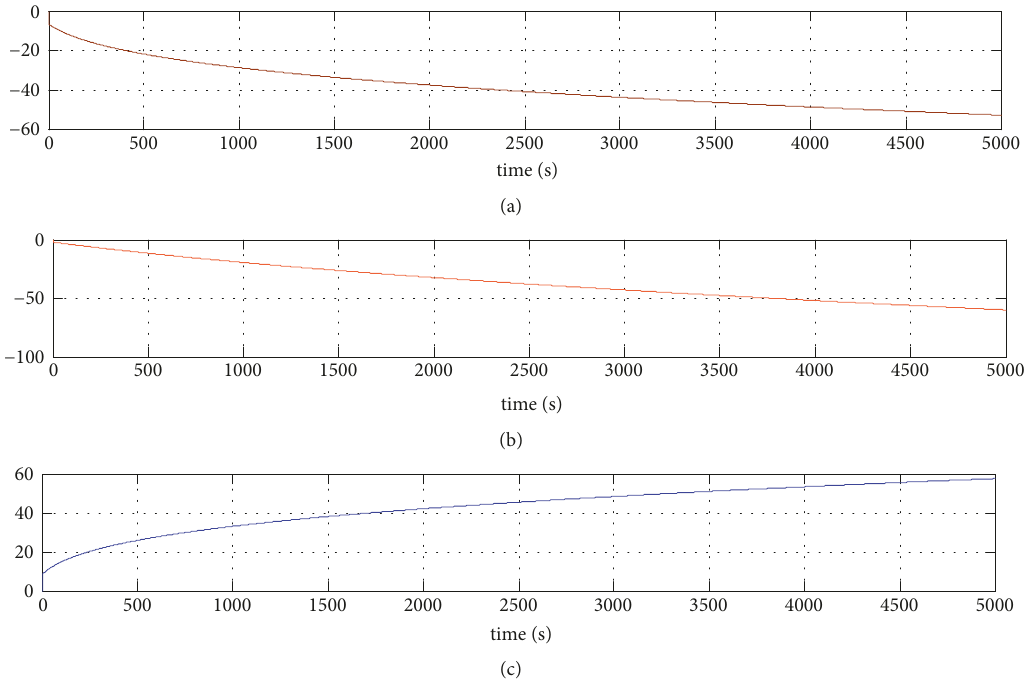
Figure 6: Drift of the unknown parameter estimations: (a) ̂𝑎 , (b) ̂𝑐 , and (c)